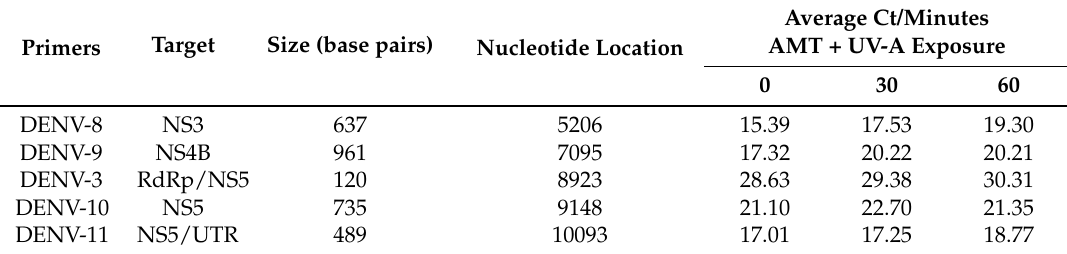
Table 5. Five PCR targets in DENV and the cycle thresholds (Cts) produced after 0 min (negative control), 30 min, and 60 min exposure to UV ‐ A in the presence of 4 ′‐ aminomethyl ‐ trioxsalen (AMT).